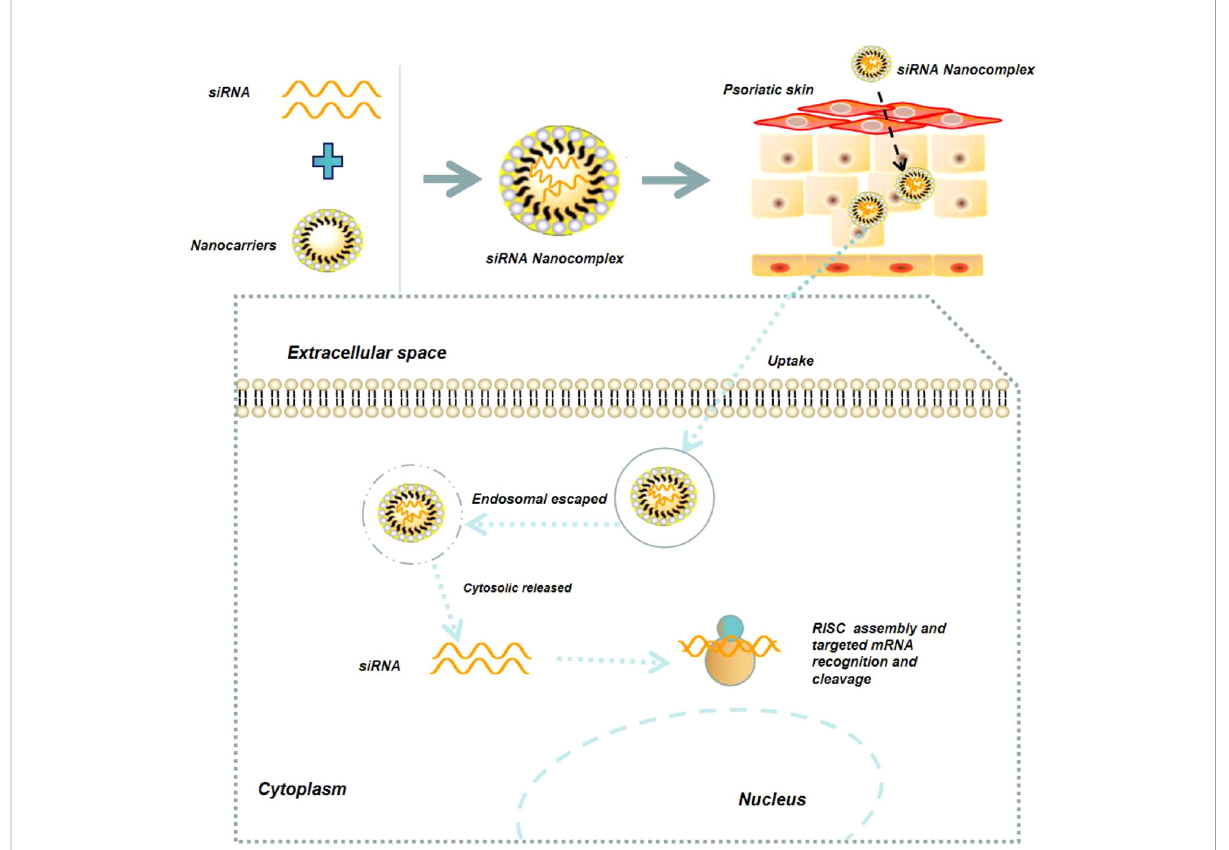
FIGURE 6 Schematic illustration of NPs-mediated delivery of nucleic acid drugs ( e.g. , siRNA) for the treatment of